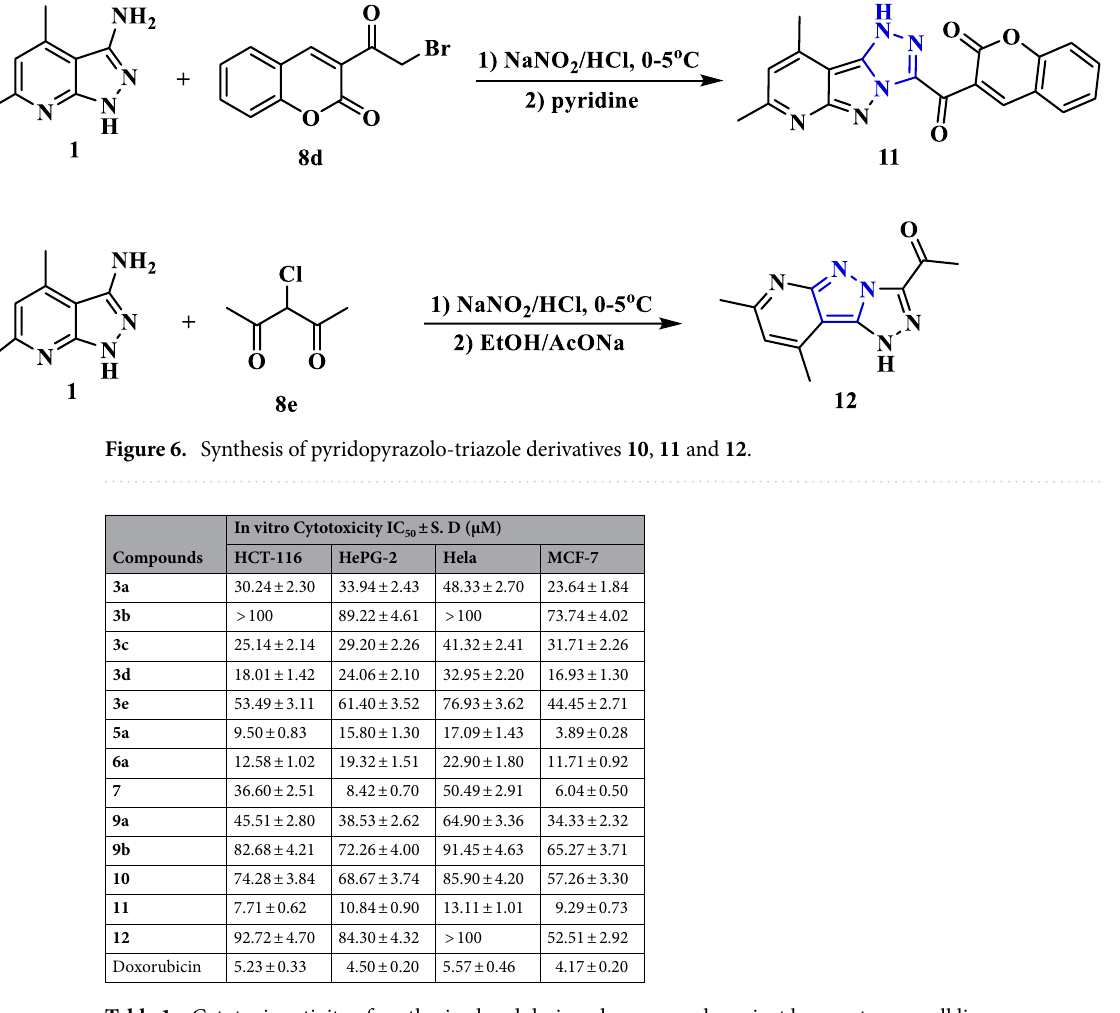
Table 1. Cytotoxic activity of synthesized and designed compounds against human tumor cell